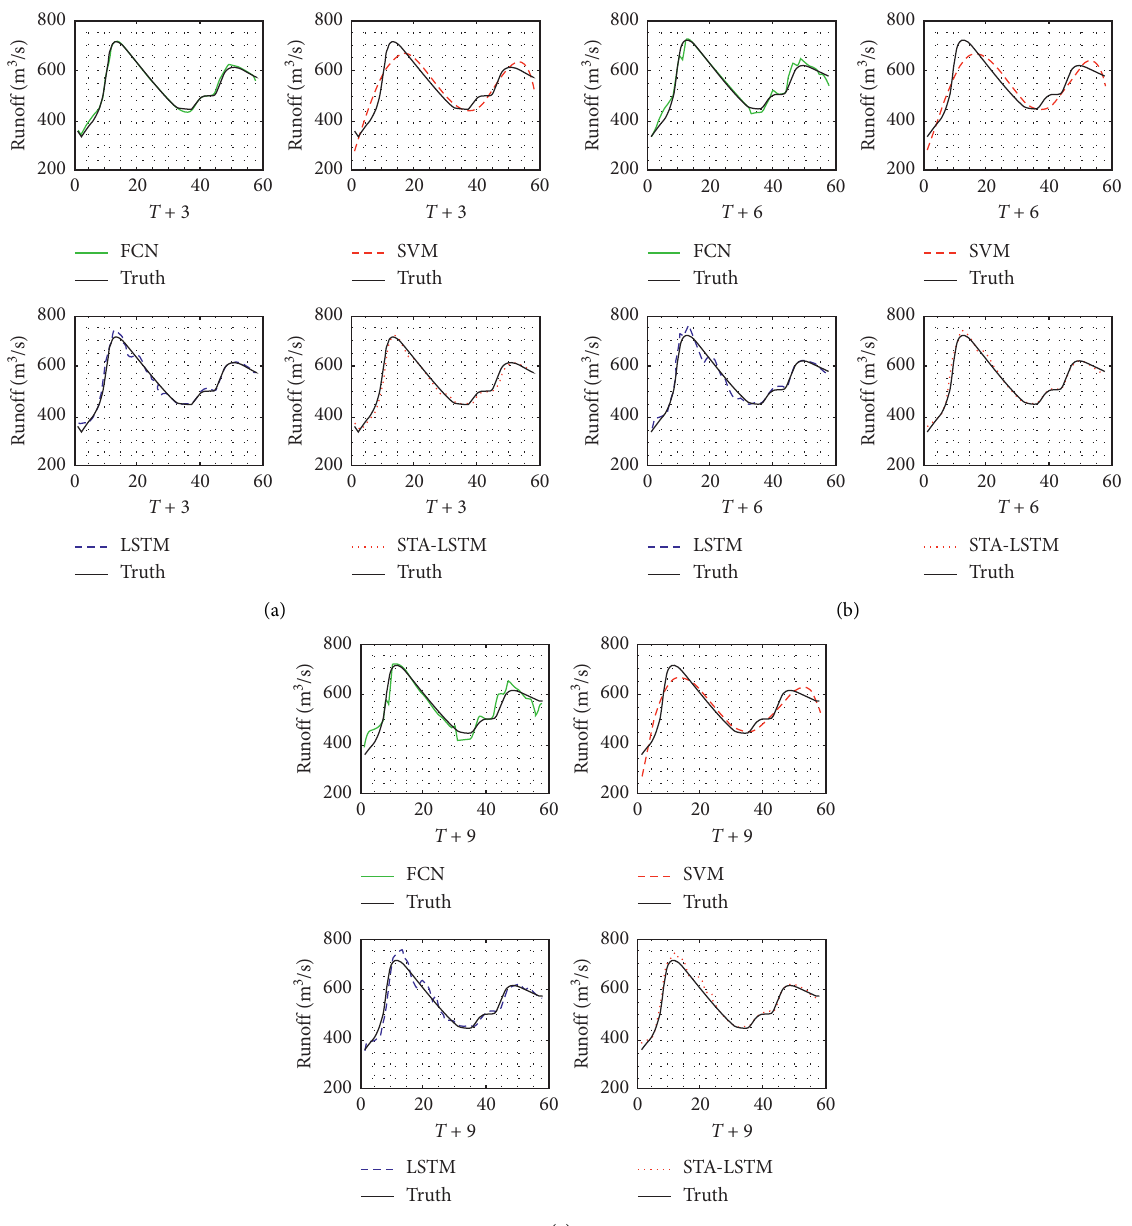
Figure 6: Comparisons in forecasting run-off values among STA-LSTM and other comparative methods, where three groups of plots refer to forecasting results performing for (a) T +3, (b) T +6, and (c) T +9,